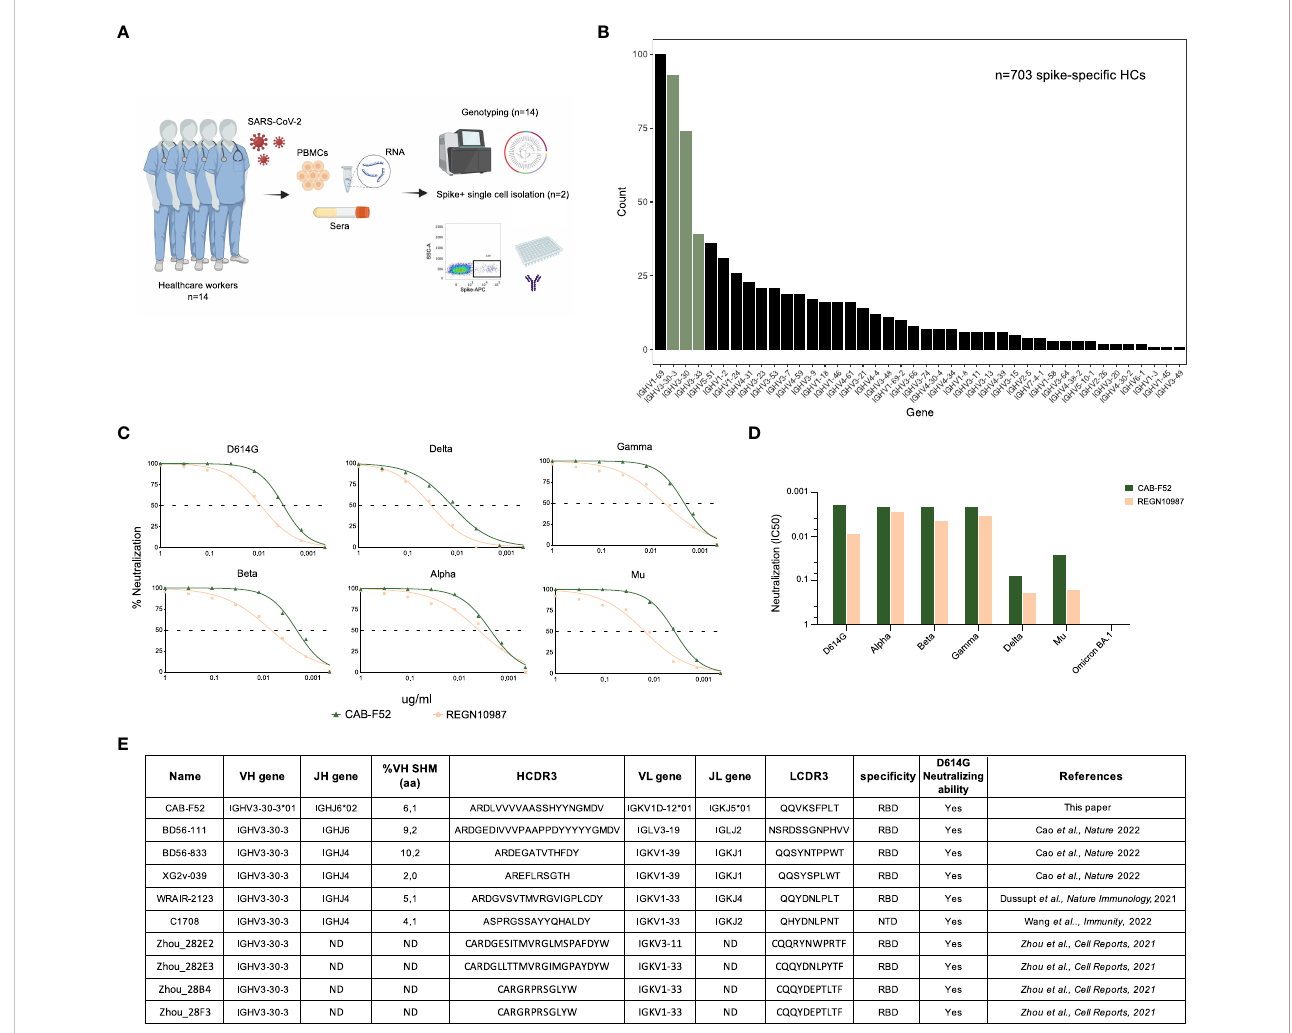
FIGURE 1 Spike HCs frequently use IGHV3-30 group of genes. (A) A schematic representation of the SARS-CoV-2 cohort consisting of 14 individuals. PBMCs, sera and RNA samples were isolated from each of these individuals. The genotyping of 14 study participants was done using the RNA sample. Two of the 14 individuals ’ PBMCs were used to isolated S-speci fi c HCs and subsequent antibody expression. (B) A bar plot showing the IGHV gene usage of S-speci fi c HCs with IGHV3-30 group highlighted in olive green. (C) Titration curves showing percent neutralization of CAB-F52 and REGN10987 against VoCs. (D) IC50 neutralization values of CAB-F52 and REGN10987 against the VoCs. (E) A table showing the genetic properties, speci fi city, and neutralization activity of CAB-F52 and several IGHV3-30-3-using mAbs from the